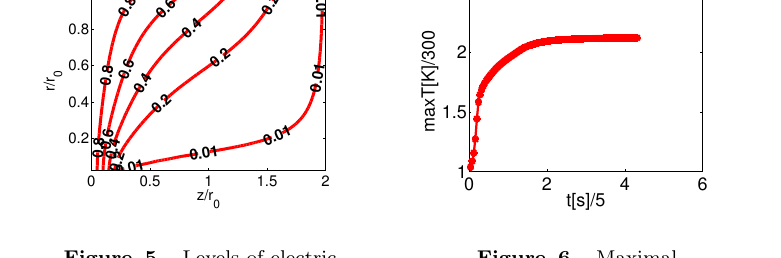
Figure 5. Levels of electric current for x 1 = 0 . 25 ,x 2 = 2.